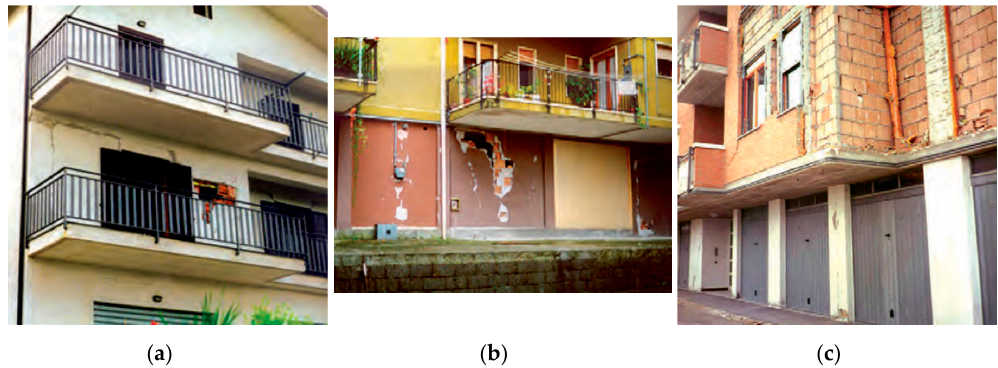
Figure 2. Examples of Medium-Severe and Very Heavy damage to infills: horizontal and vertical cracks between infill and beams/columns—widespread damage D2–D3 and locally D4–D5 ( a ); damage D4–D5 to infills ( b ); damage D4–D5 with out-of-plane collapse of one infill leaf ( c )—adapted from [4].